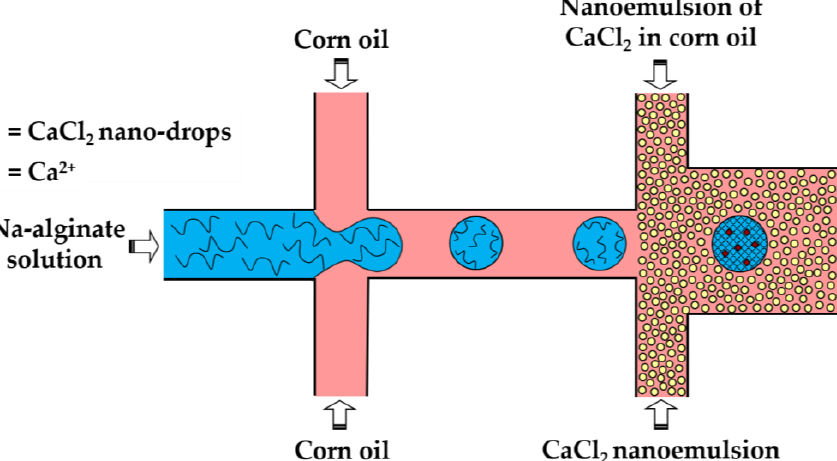
Figure 8. Formation of Ca-alginate beads by external gelation in a chip consisting of two serial cross-junctions using nanodroplets of an aqueous CaCl 2 solution as the crosslinking agent [43]. A slow gelation by CaCl 2 nanodroplets may cause the coalescence of alginate droplets and clogging of the outlet channel. A possible solution could be to increase the length of the downstream channel, which may lead to excessive pressure buildup in the chip, particularly single emulsion method can be replaced by the double emulsion method, as shown in Figure 9.